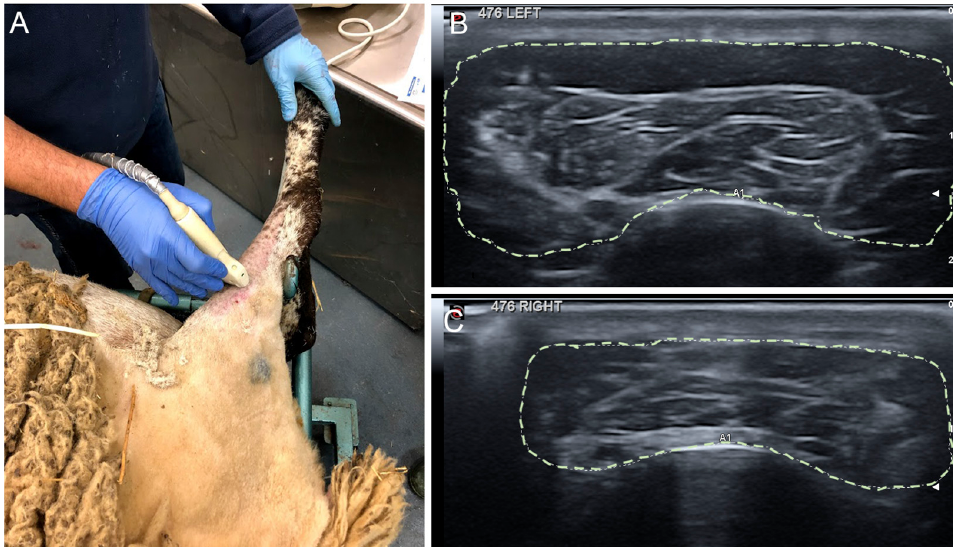
Figure 11. Procedure for the echographic imaging. The ultrasound probe was placed with conductive gel on the mid of the TA muscle mass ( A ). Sample images of the echography of TA muscle, delineated by discontinuous line in a control hindlimb ( B ), and in an operated hindlimb ( C ).